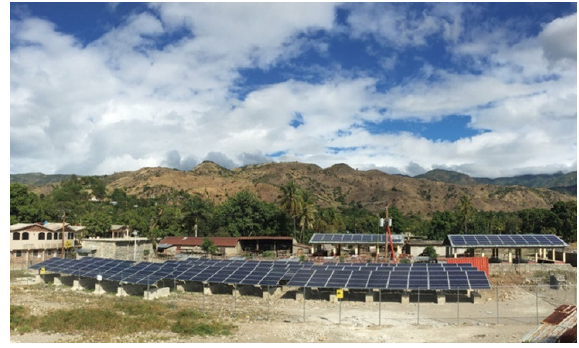
Fig. 7 Les Anglais solar microgrid in Haiti [36] .